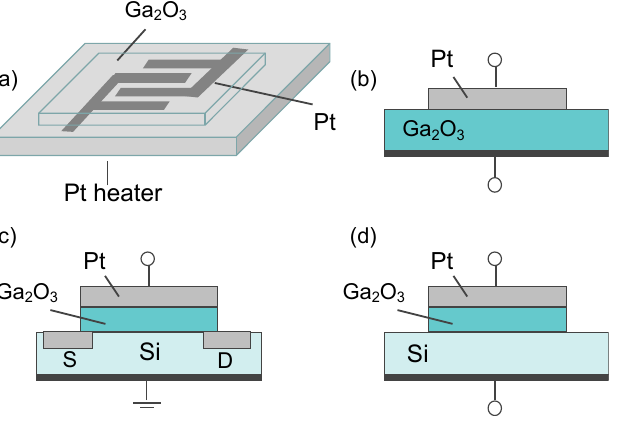
Figure 9. Schematic device structures for ( a ) resistor ‐ type ( b ) SBD ‐ type, ( c ) FET ‐ type, and ( d ) capacitor ‐ type Ga 2 O 3 ‐ based gas sensors. Redrawn with permission from G. Korotcenkov [187]. Copyright 2014 Springer.